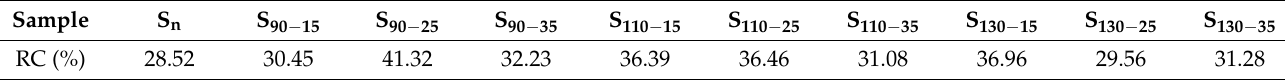
Table 3. RC of native and HMT HB